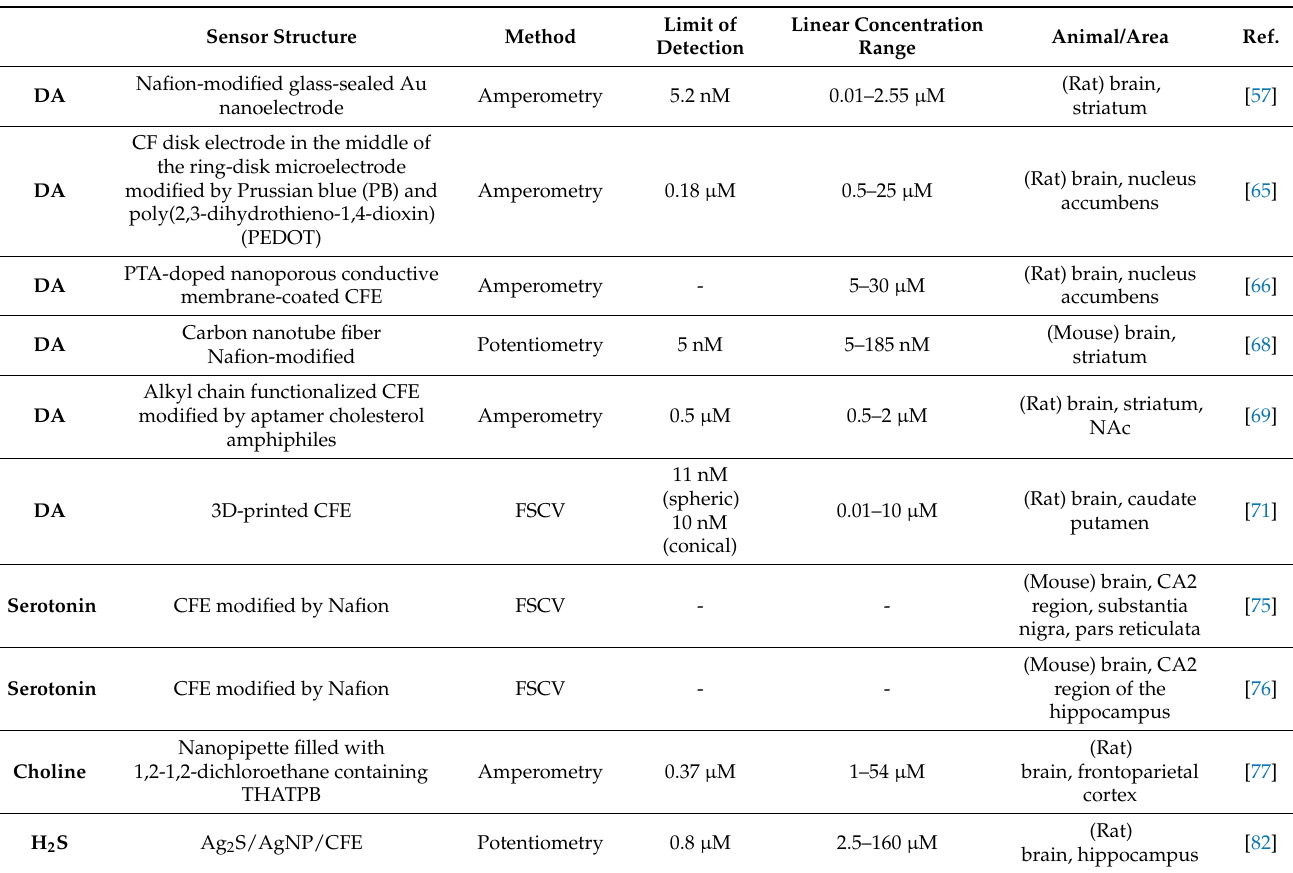
Table 1. Detection neurotransmitters in